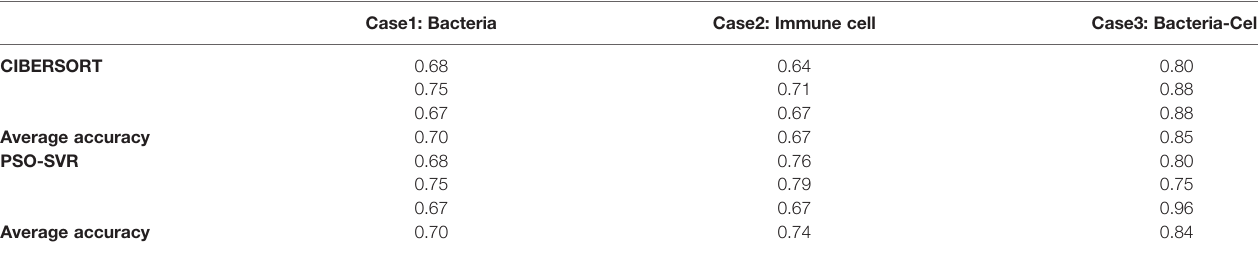
TABLE 4 | Classi fi cation effect of liver cancer samples under different input features. Case1: Bacteria Case2: Immune cell Case3: Bacteria-Cell CIBERSORT